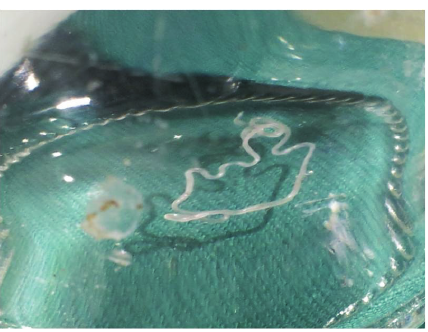
Figure 4: Specimen of Dirofilaria repens